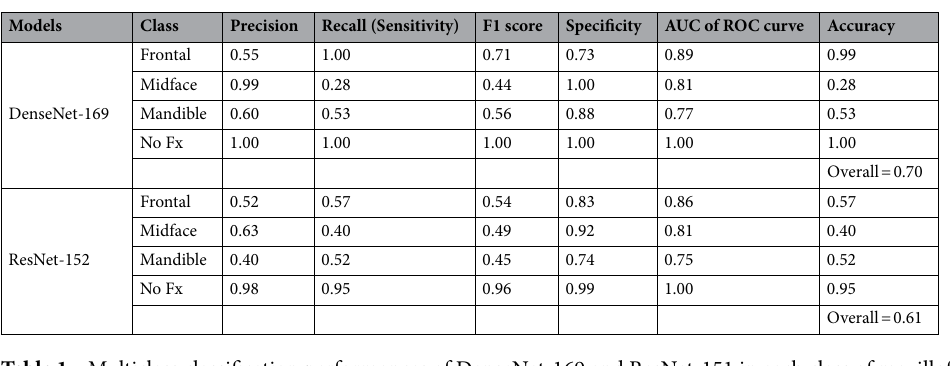
Table 1. Multiclass classification performances of DenseNet-169 and ResNet-151 in each class of maxillofacial fractures. AUC area under the receiver operating characteristic ( ROC ) curve, Fx fracture.